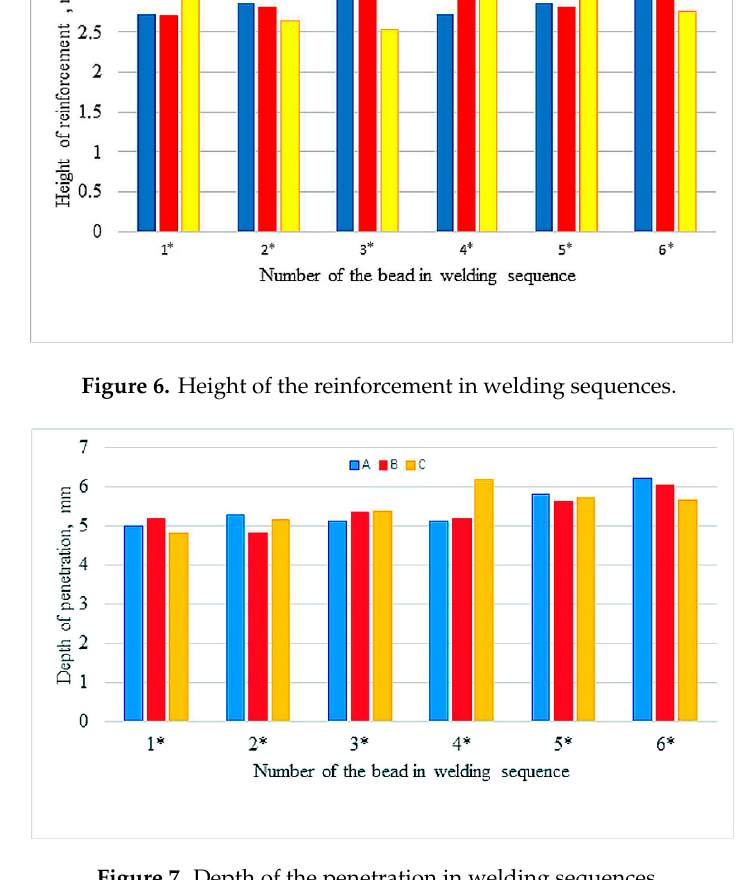
Figure 7. Depth of the penetration in welding sequences.